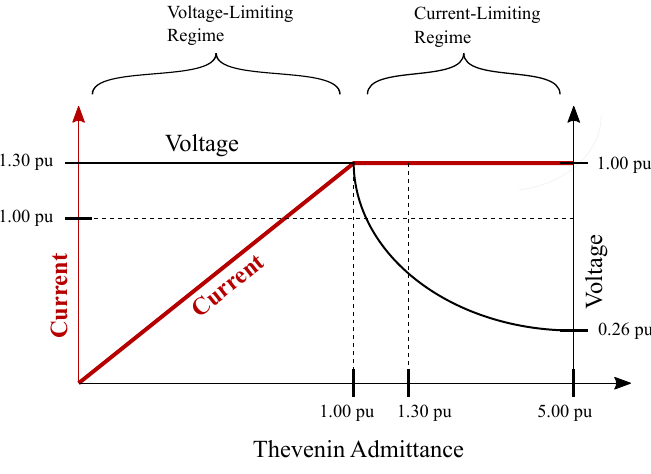
Figure 7. Graphical illustration of constraints for a grid-forming